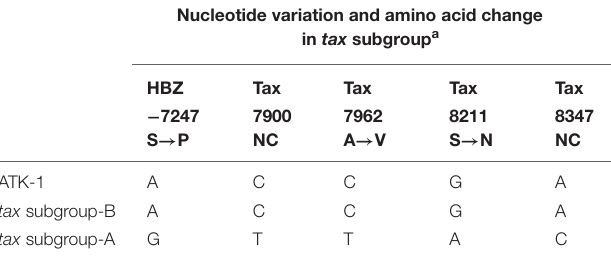
TABLE 1 | Nucleotide variations specific to HTLV-1 tax subgroup. Nucleotide variation and amino acid change in tax subgroup